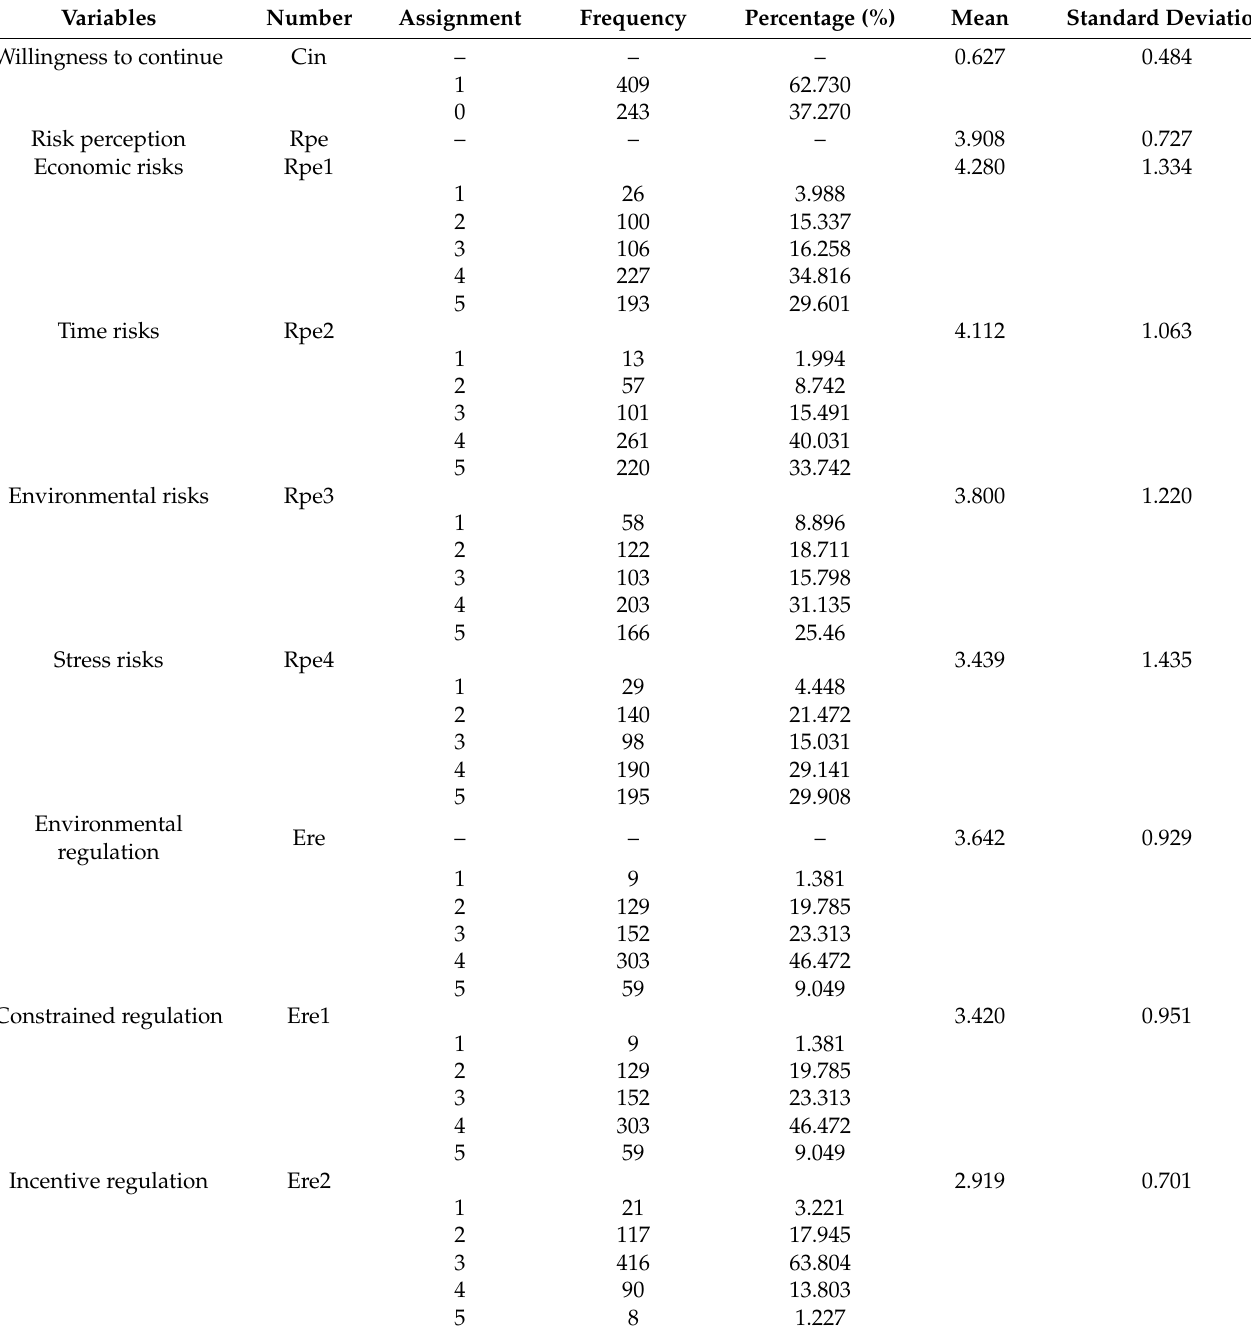
Table 3. Descriptive statistics of the explained variables and core explanatory variables ( n =